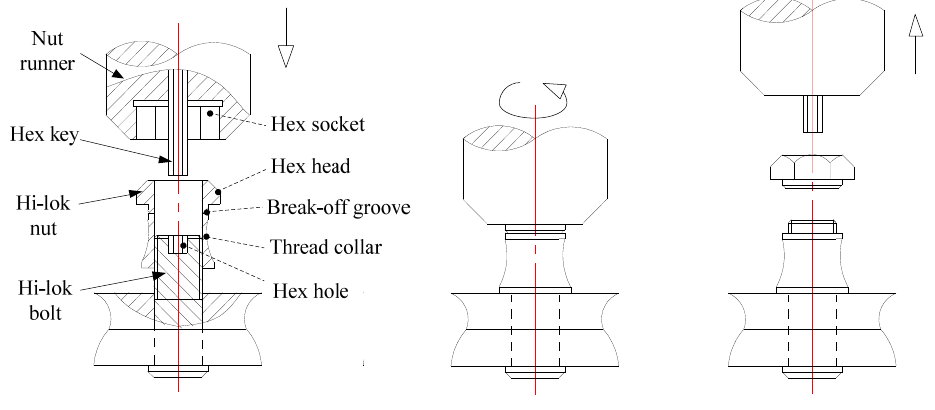
Figure 1. Installation process of hi-lok nut.